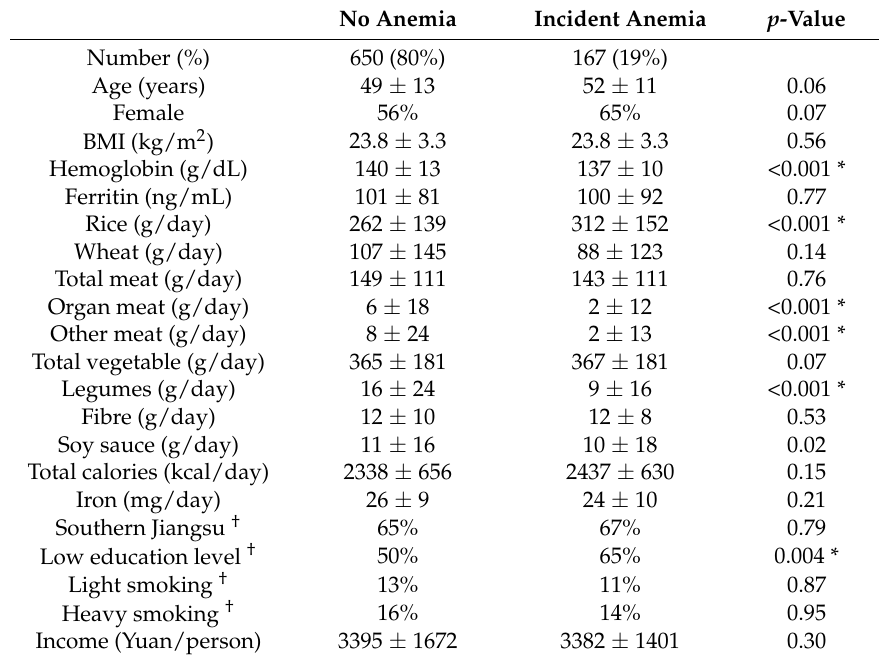
Table 3. Baseline associations (sex-stratified, age matched, and adjusted) with incident anemia during a five-year follow-up (Figure 1H,J).